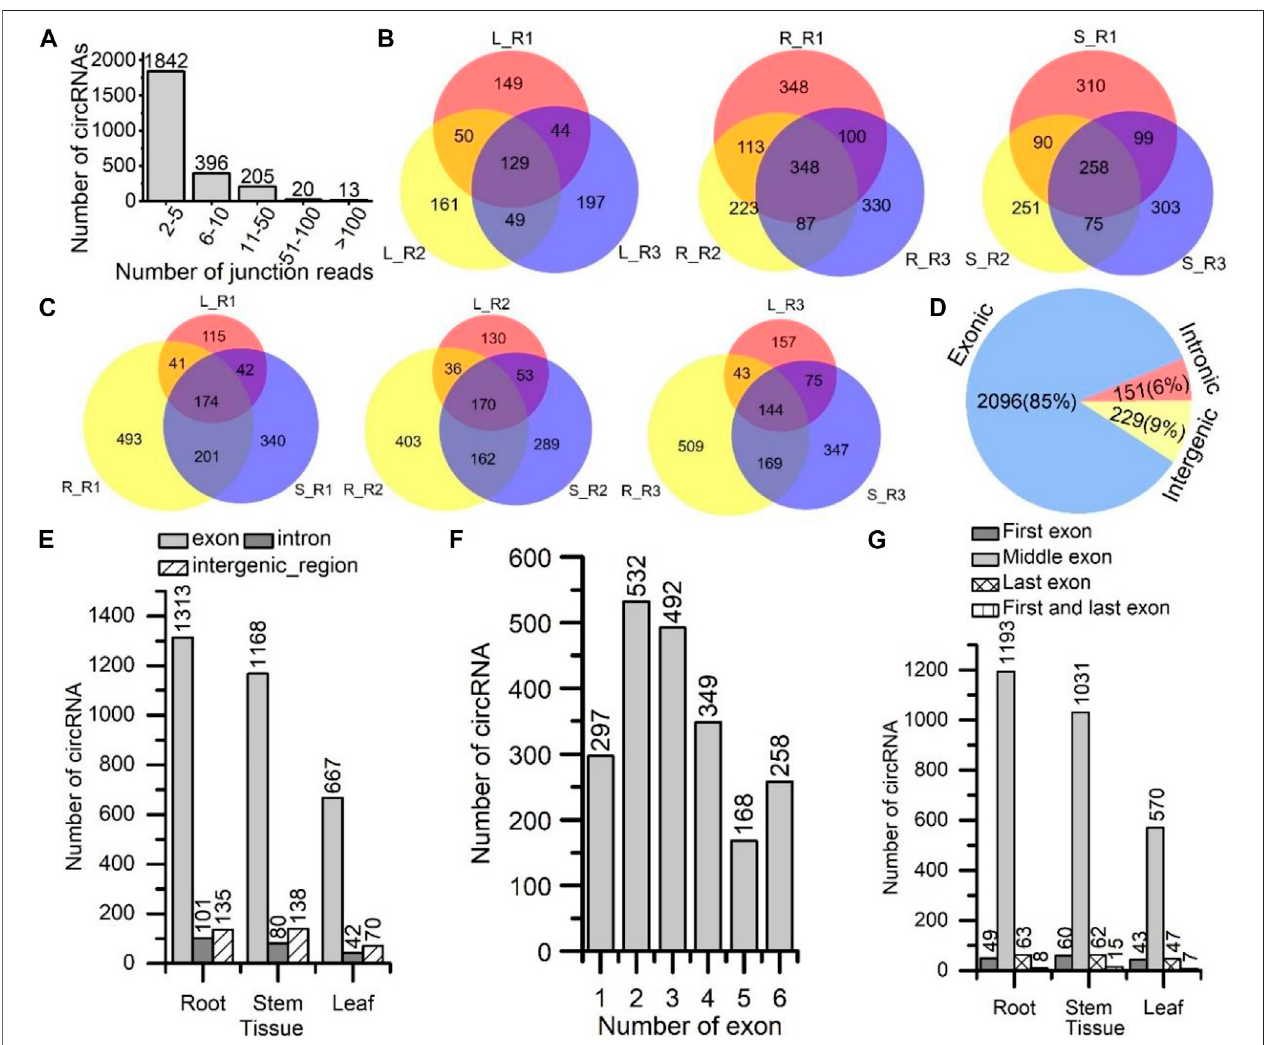
FIGURE 1 | Identi fi cation and characterization of circRNAs in S. miltiorrhiza . (A) The number of circRNAs categorized by the number of associated junction reads. The X-axis shows the number of junction reads. The Y-axis shows the number of circRNAs. (B) Venn diagrams comparing the circRNAs identi fi ed among three plant replicate samples for the same tissue type. L, leaf; R, root; S, stem; R1, replicate sample from plant No. 1 (red); R2, replicate sample from plant No. 2 (yellow); R3, replicatesamplefromplantNo.3(blue). (C) VenndiagramscomparingthecircRNAsidenti fi edamongthreetypesoftissuesforthesameplantindividuals(No.1,2, and 3), leaf (L: red), root (R: yellow), and stem (S: blue). (D) Numbers of circRNAs are categorized by origin types: exon, intron, and intergenic region, across all three tissues. (E) Numbers of circRNAs are categorized by the types of their origins: exon, intron, and intergenic region, in each tissue. The X-axis shows the tissue type. (F) The numbers of circRNAs are categorized by the numbers of back-splicing exons that the circRNA had spanned. The X-axis shows the numbers of exons. (G) The numbersofcircRNAsarecategorizedbytheirorigins: fi rstexon,middleexon,lastexon, fi rst,andlastexon.TheX-axisshowsthetissuetype.In A,E,F,andG ,theY-axis is the number of circRNAs. The number on the top of each bar represents the number of circRNAs.